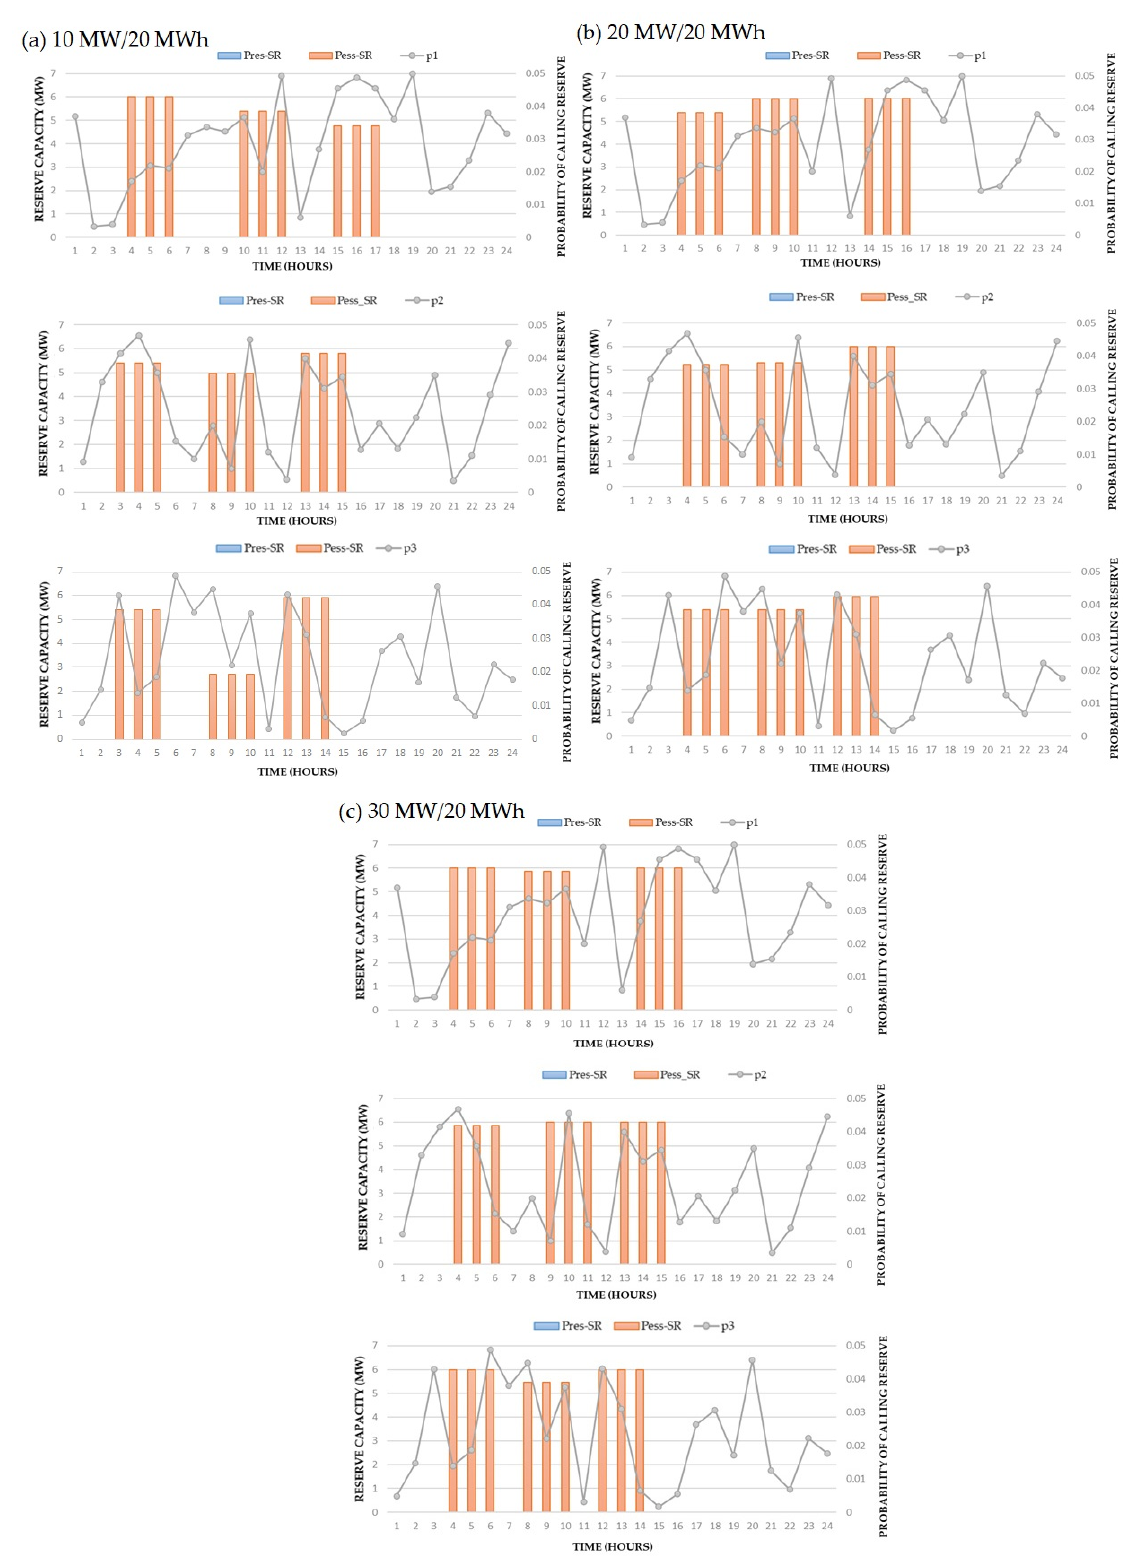
Figure 14. VPP’s reserve capacity for different ESS power ratings and reserve probability scenarios.